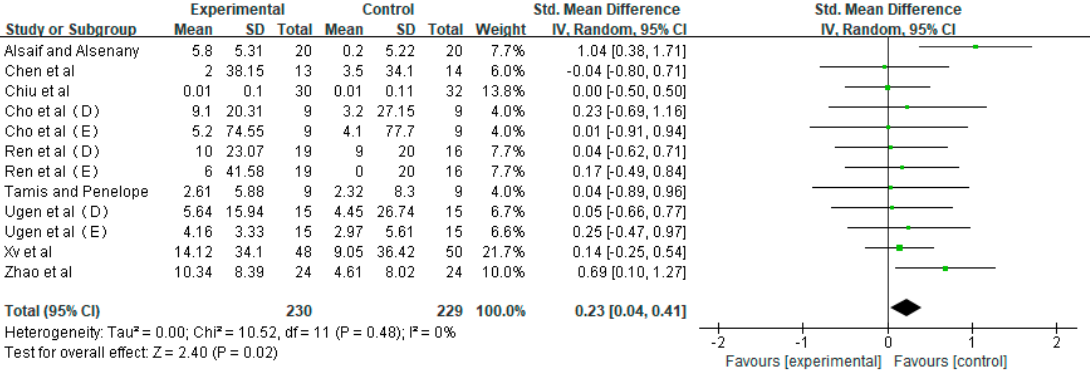
Figure 2. E ff ects of VRGs on Gross Motor Skills of Children with CP.